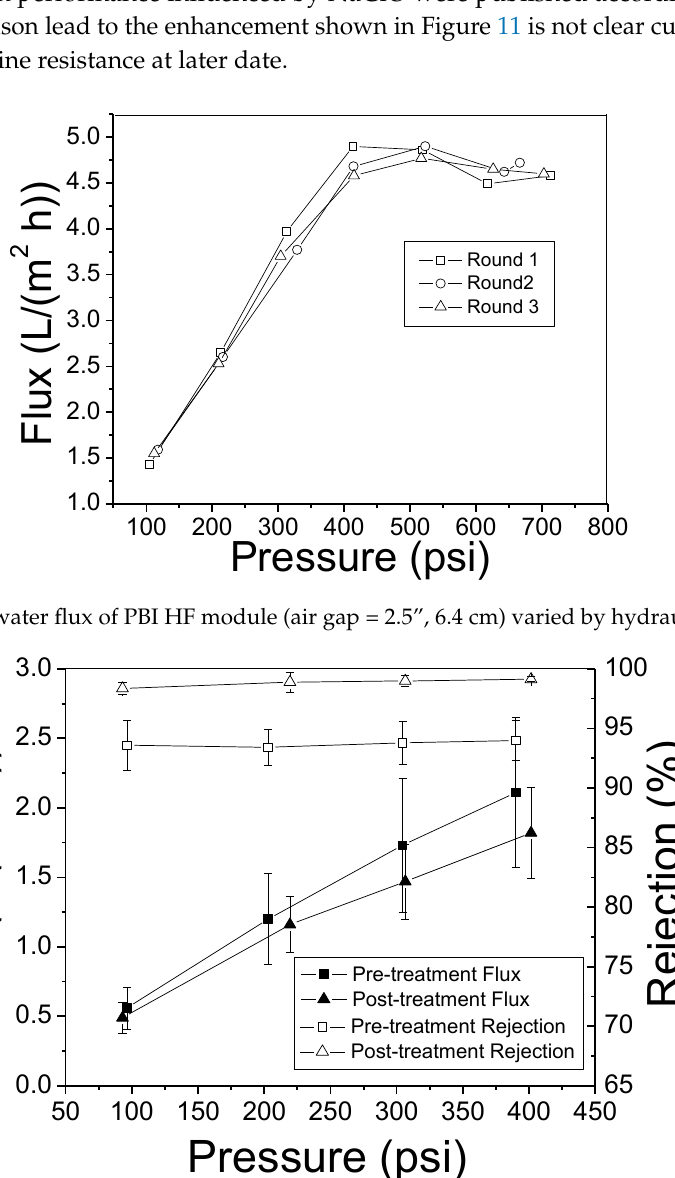
Figure 11 . Desalination performance of PBI HF module (air gap = 2.5″, 6.4 cm) before and after surface Figure 11. Desalination performance of PBI HF module (air gap = 2.5”, 6.4 cm) before and after surface modification (Test condition: 2000 ppm NaCl, pH 7.0 and 25 ± 2 ◦ modification (Test condition: 2000 ppm NaCl, pH 7.0 and 25 ± 2 °C).